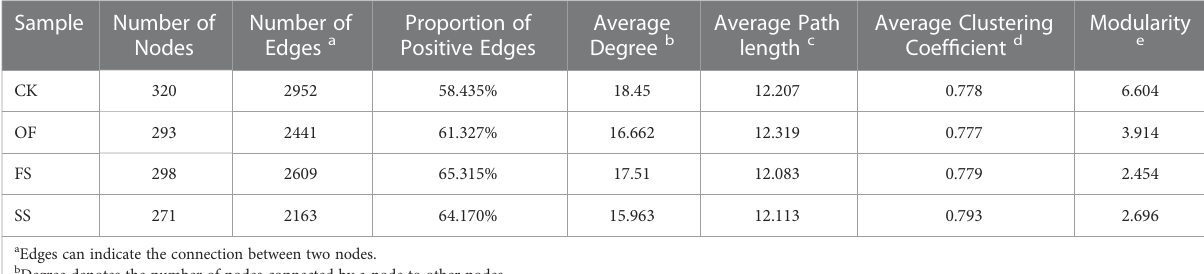
TABLE 3 Co-occurrence network properties within bacterial taxa in different samples in Figure 5 .